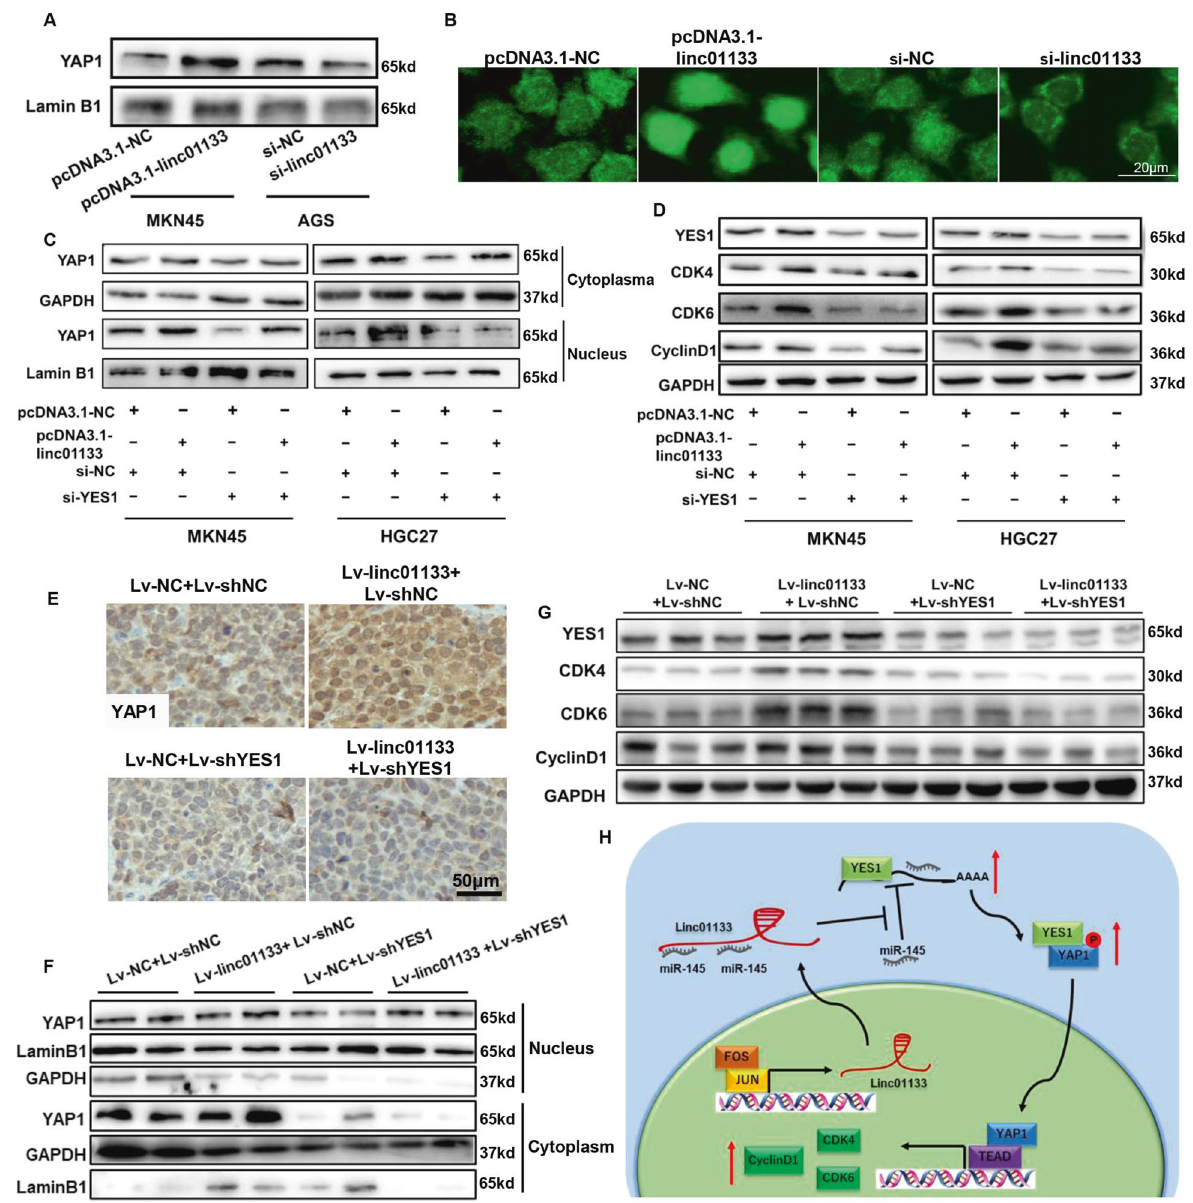
Fig. 7 YES1 confers the function of linc01133 via promoting YAP1 nuclear translocation. A , B Western and fl uorescence immuno-staining showed that over-expressing linc01133 increased while knocking-down linc01133 decreased nuclear YAP1. C Simultaneous YES1 knocking- down ameliorated linc01133 induced YAP1 nuclear accumulation in MKN45 and HGC27 cells. D Western blotting showed that CDK4, CDK6 and cyclin D1 expression was in good accordance with nuclear YAP1 accumulation. E , F Immunohistochemistry staining and western blotting showed YAP1 nuclear accumulation in tumor xenografts. G Western blotting for key regulators in G1/S phase transition in tumor xenografts. Each experiment was performed in triplicates. H . Schematic illustration of the mechanisms that linc01133 promotes the growth of gastric cancer